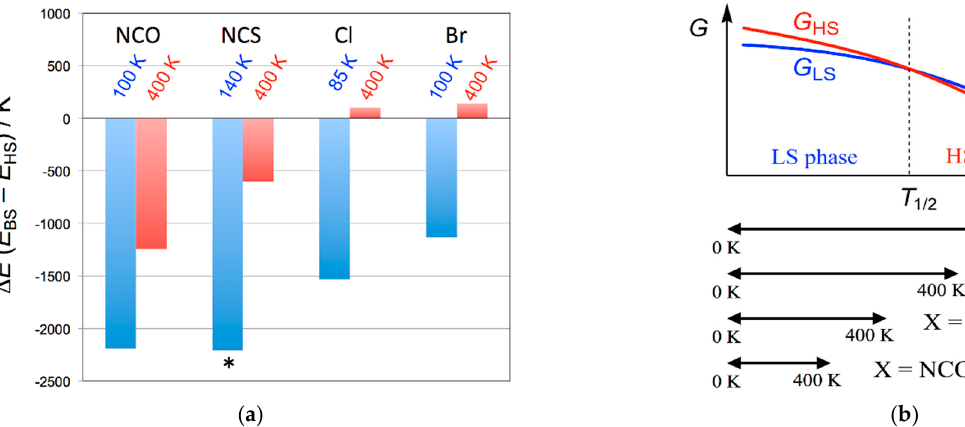
Figure 13. ( a ) Temperature dependence of the calculated energy gap between the broken-symmetry singlet state (BS) and quintet state (HS) on [Ni(phpyNO) 2 X 2 ] (X = NCO, NCS, Cl, Br). The temperatures where the structures were determined are noted. An asterisk indicates an averaged value of the independent molecules. ( b ) A schematic Gibbs energy diagram for [Ni(phpyNO) 2 X 2 ]. The experimental windows are also shown in a lower panel. Adapted from [122], published by MDPI, 2020.